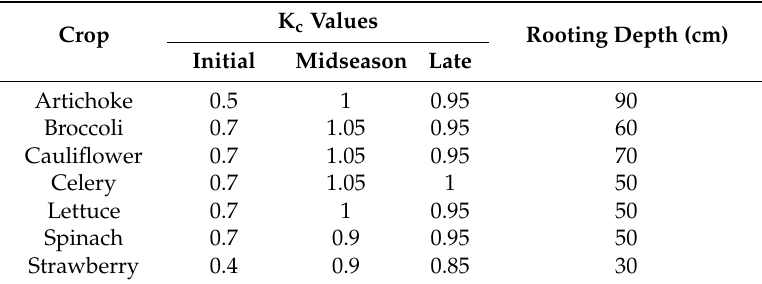
Table A2. Time-averaged crop coefficients and maximum rooting